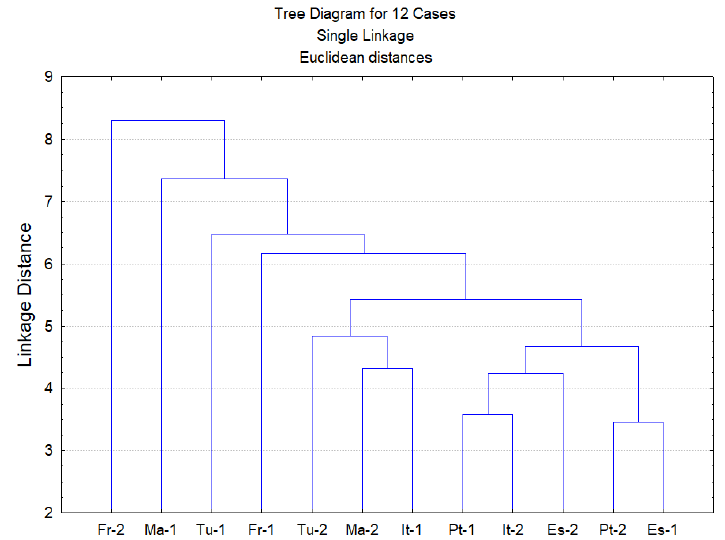
Figure 4. Dendrogram obtained by cluster analysis of the family classes of epicuticular wax compounds from 12 leave samples from six provenances (ES—Spain; FR—France; IT—Italy; MA—Morocco; PT—Portugal; TU—Tunisia).